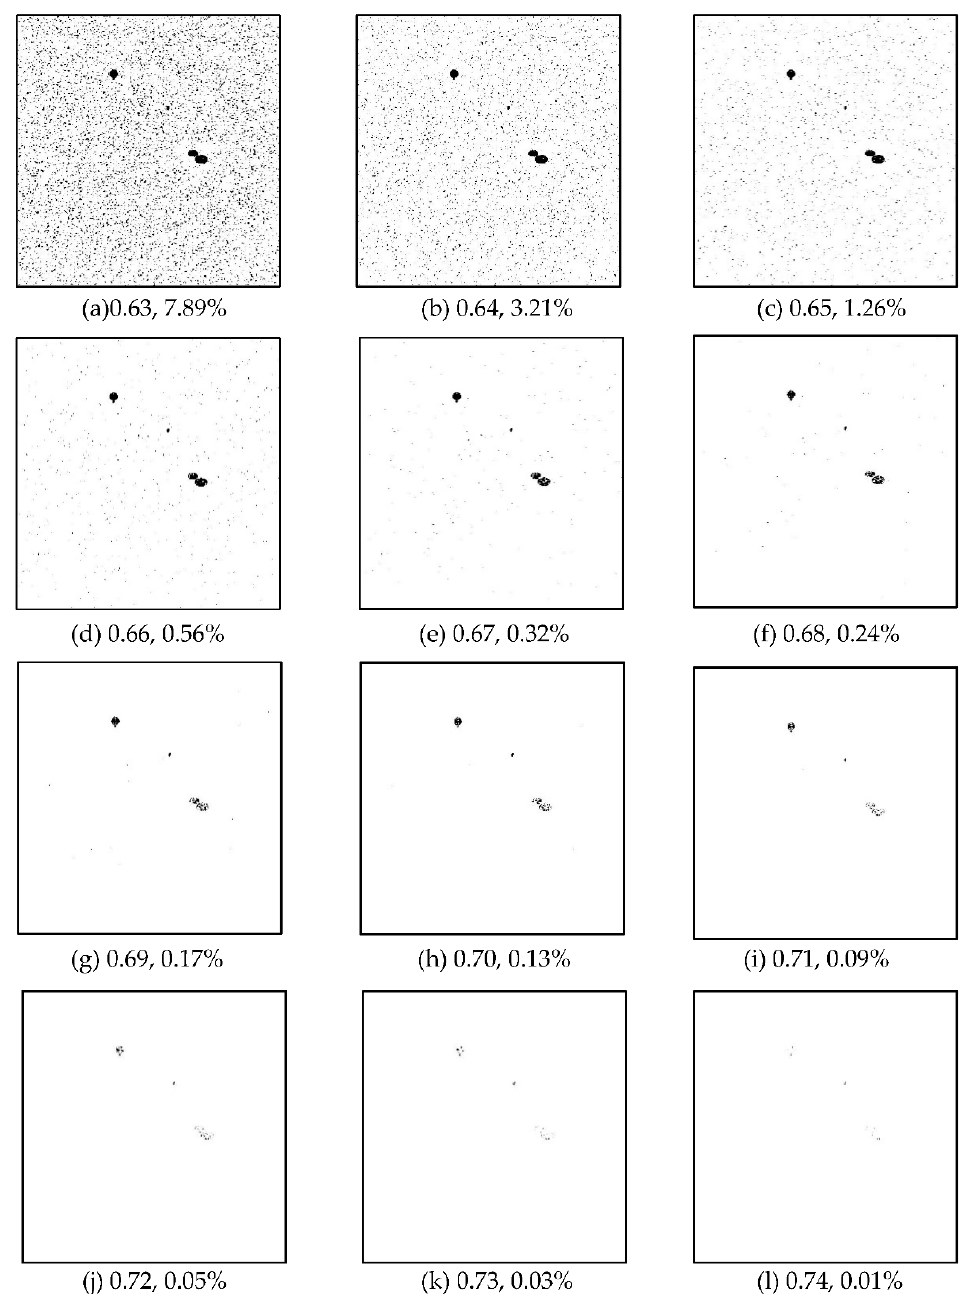
Figure 25. Binary images with different sensitivity factors and percent of porosity. As can be seen from the images, increasing the sensitivity factors reduces the black spots resulting from the noisy background, but it alters the pore’s morphological features dramatically. A sensitivity factor of 0.69 seems relatively better and it will be selected to binarize all 3000 slices since it yielded the most accurate percent of porosity of 0.17%, which is close to the actual percent of pore for the original slice with a value of 0.1785%. It is worth noting that in the case of producing real porosity images, sensitivity factor selection will be subjective and difficult since the actual percentage of porosity will be unknown. The average percent of pore for 3000 slices was 0.0203, while the average percent of pore for 3000 binarized images is overestimated with a value of 0.0424, so the absolute error is 0.0221. The prediction accuracy with a difference less than a threshold of 0.02 (percent of observations with error less than 0.02) is 68.60%.